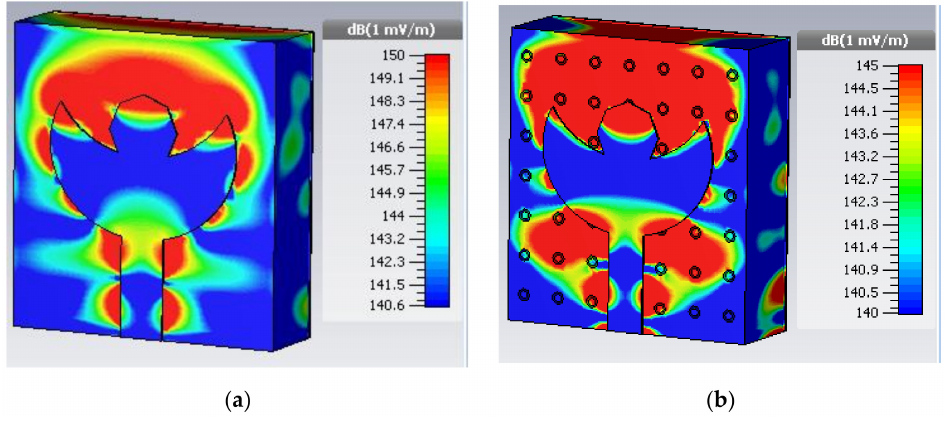
Figure 12. Electric Field distribution at 0.63 THz ( a ) Type-A antenna ( b ) Type-D